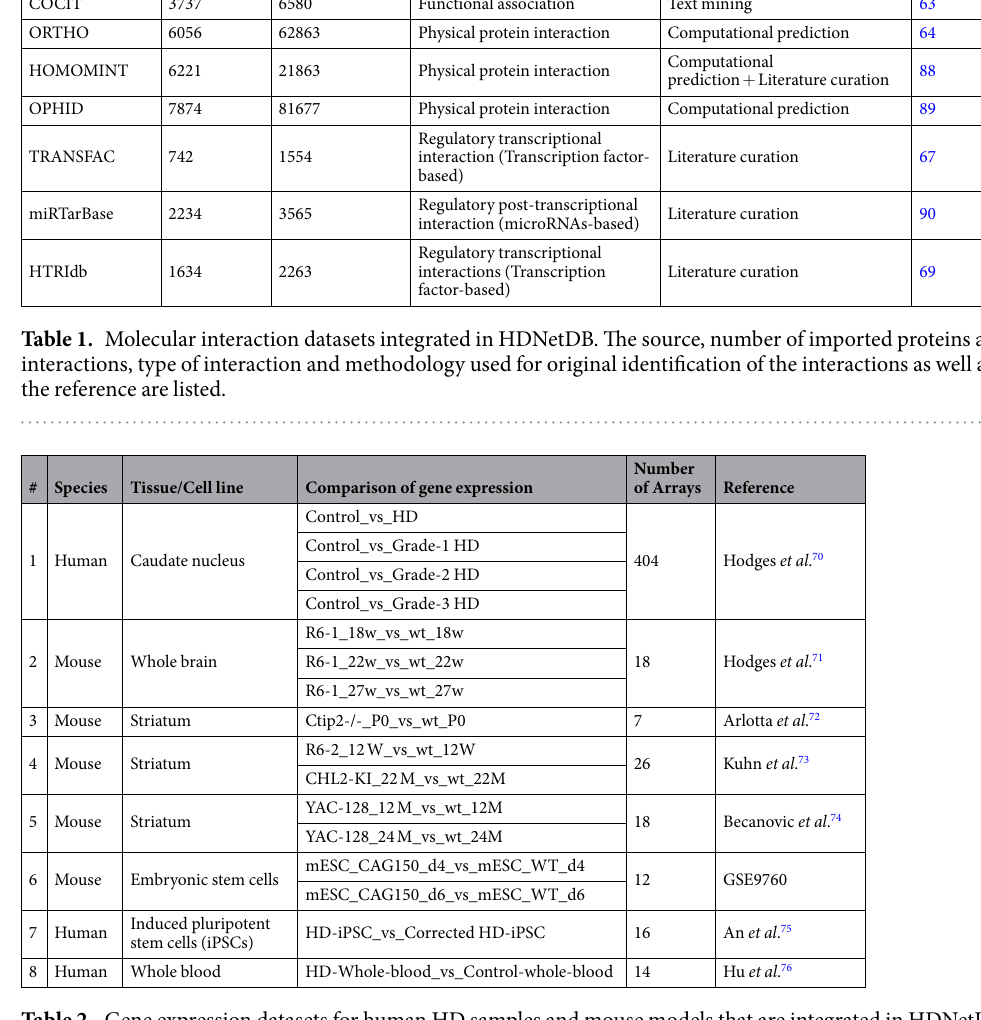
proteins were detected as directly or indirectly interacting with HTT. This gene set was derived by querying HDNetDB for HTT interactors. (iii) NDGA ( Neurological Diseases Gene Association ) consists of 2698 genes that have a genetic association with neurological diseases as indicated in the Genetic Association database 81 . The data were originally extracted from published papers on candidate genes and genome wide association studies. (iv) HDTM ( Huntington’s Disease genes through Text Mining ) was derived through text mining implemented in the GeneCards database 82 using “Huntington’s disease” as a keyword search. The text mining returned 673 genes associated with HD. (v) NDMOD ( Neurodegeneration Modifiers ) is derived from independently compiled gene list comprising genetic modifies of neurodegeneration identified in various model systems. The list was created by review of published genetic screens undertaken in S. cerevisae , C. elegans and D. melanogaster models 83 . After mapping to Entrez Gene IDs of the corresponding human orthologs, 217 genes remained.